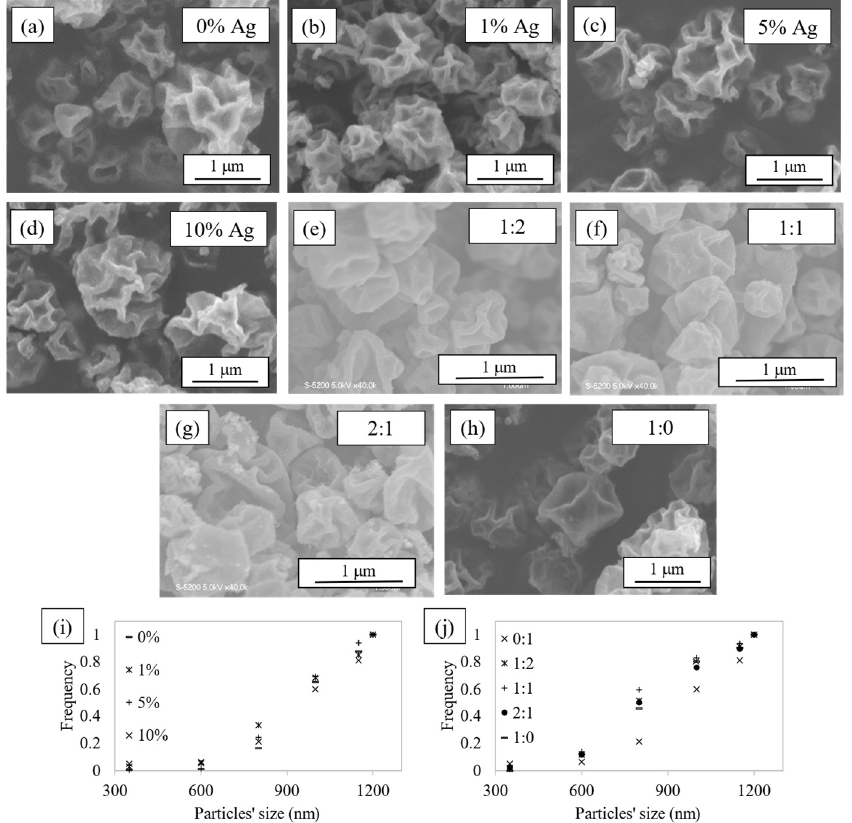
Figure 1. Morphology of ( a ) pristine ZnO, ( b – d ) ZnO-Ag with Ag content of ( b ) 1 wt%, ( c ) 5 wt%, ( d ) 10 wt% fabricated at an O 2 :N 2 ratio of 0:1, ( e – h ) ZnO-Ag with Ag content of 10 wt% fabricated at different O 2 :N 2 ratios, and ( i , j ) a cumulative size distribution of the nanoparticles. TEM images (Figure 2a,b) show that the crumple-shaped spheres consisted of smaller primary nanoparticles. The EDS results (Figure 2c,d) indicated the presence of Zn, O, and Ag. In pristine ZnO, the ZnL α , ZnK α , ZnK β , and OK α peaks confirm the presence of ZnO. The AgL α peak confirms the presence of Ag nanoparticles. The CuK α and CuK β peaks correspond to the TEM grid that was used for observations in TEM measurements, and no impurities are observed in the